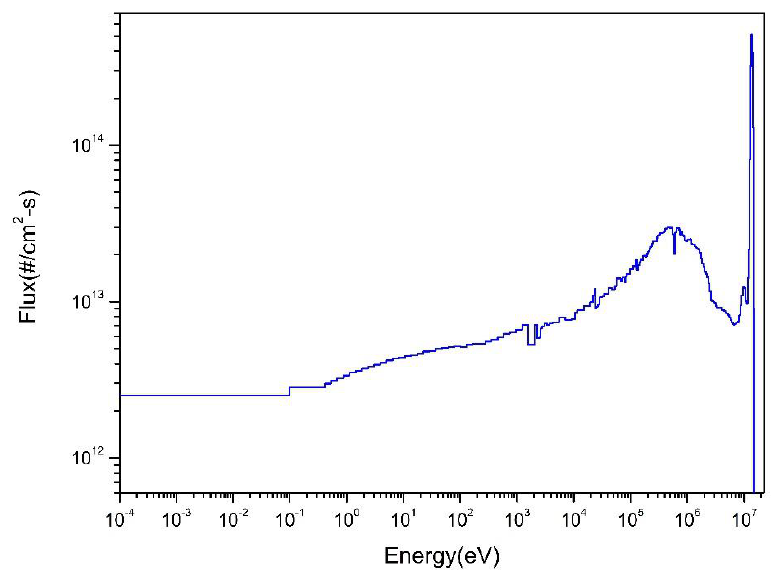
Figure 6. Neutron spectra of D-T (ITER)